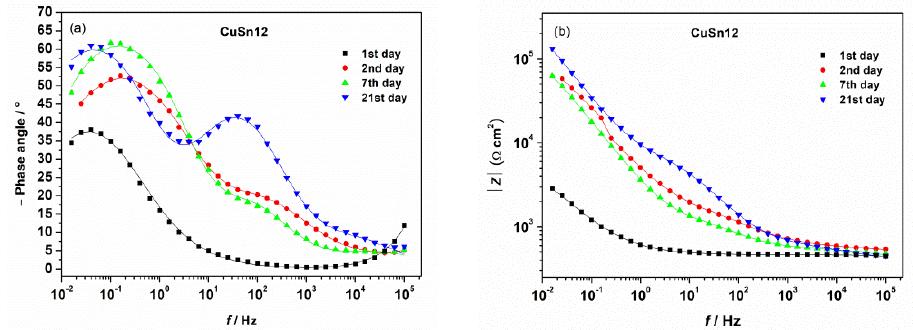
Figure 7. EIS spectra for CuSn12 bronze for continuous immersion in artificial urban rain at pH 6.5. ( a ) Bode phase angle; ( b ) Bode impedance.